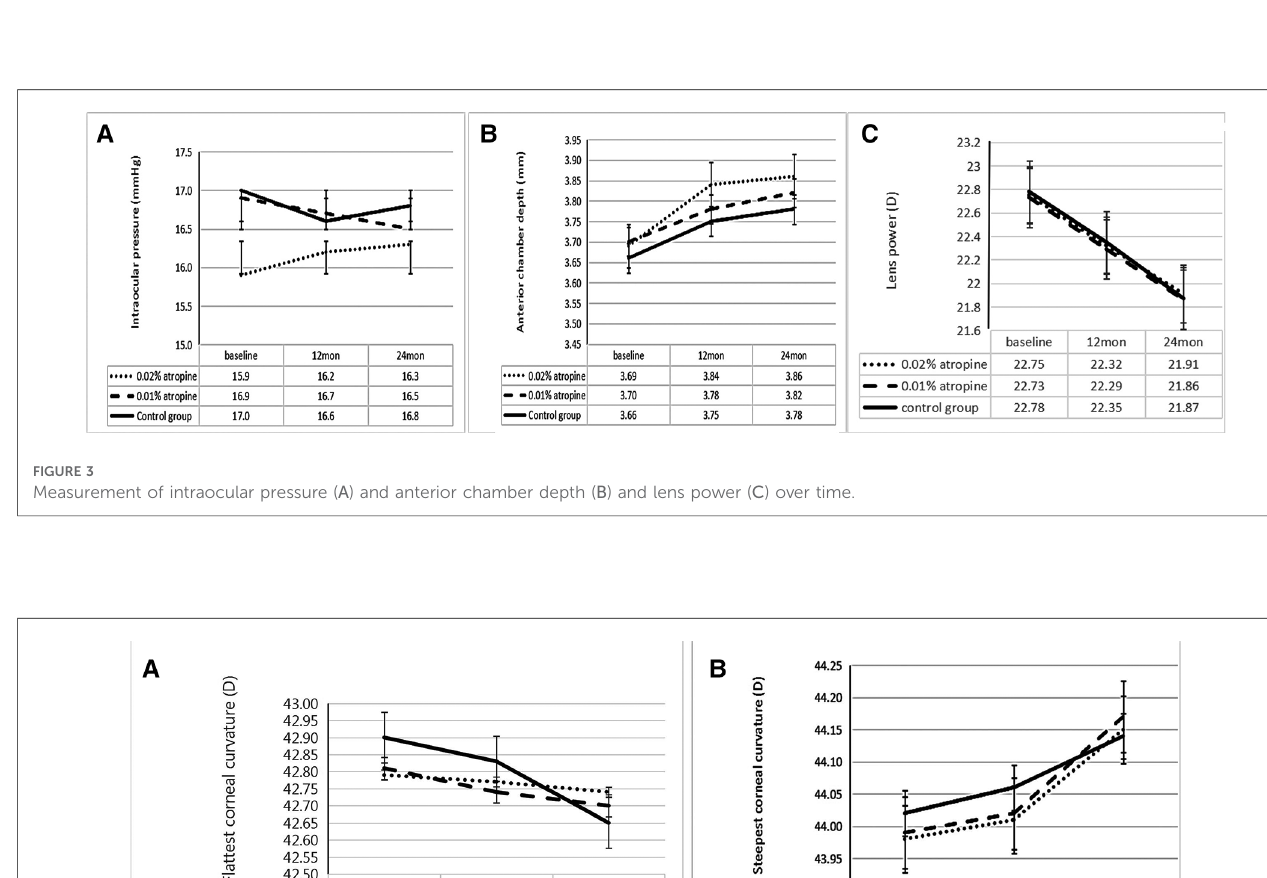
FIGURE 2 Measurement of spherical equivalent refractive error ( A ) and axial length ( B ) over time.